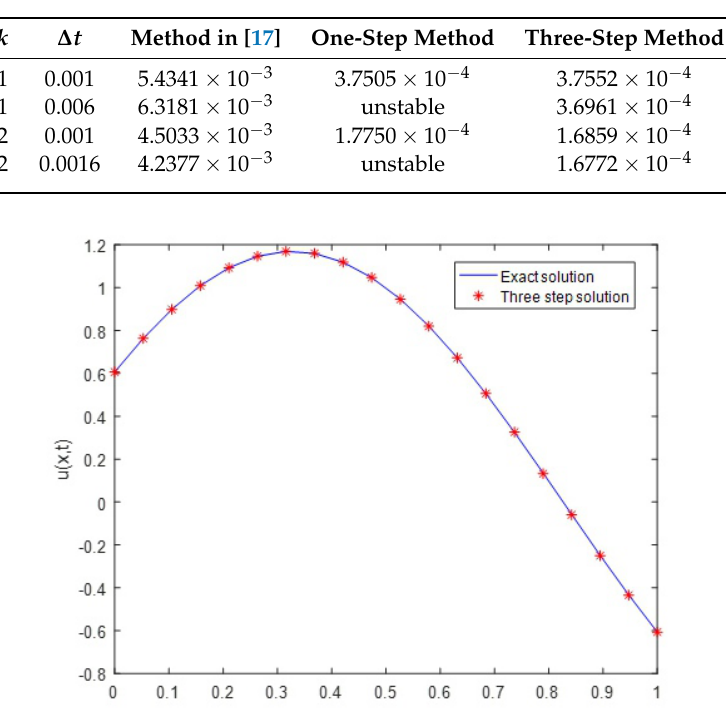
Table 4. The L ∞ error of Example 3 in M = 8.